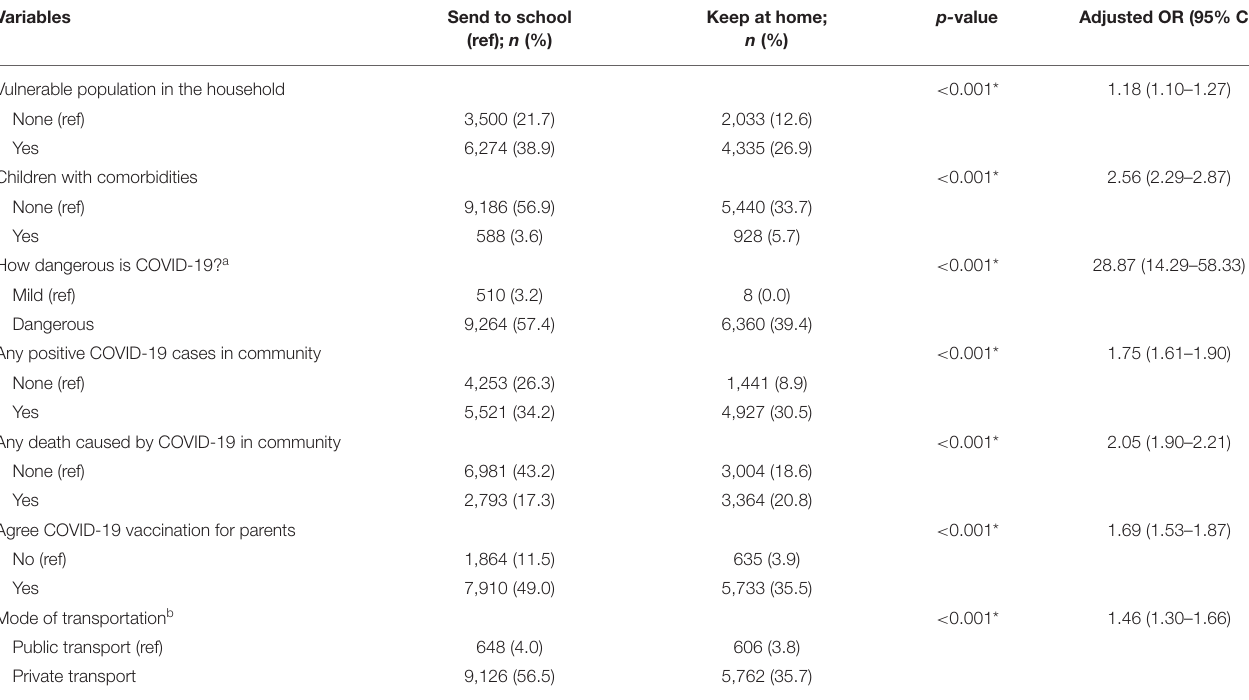
TABLE 3 | Final multivariate analysis of factors associated with parents’ attitudes toward in-school or virtual learning ( n = 16,142). Variables